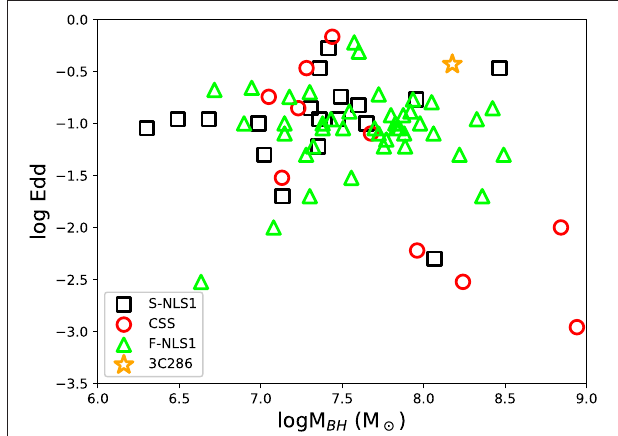
FIGURE 1 | Black hole mass vs. Eddington ratio distribution. Flat-spectrum RLNLS1s are indicated by green triangles, the red circles indicate CSS/HERG sources, the black squares indicate steep-spectrum RLNLS1s, and the orange star represents 3C 286.